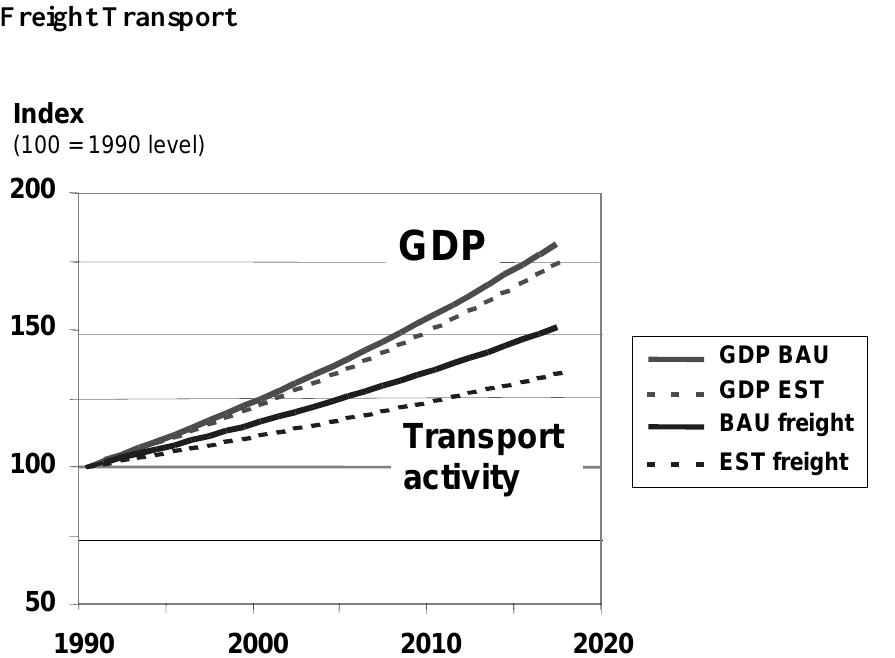
Figure 3. Evidence for relative “decoupling” of transport demand from economic growth (results from EST case